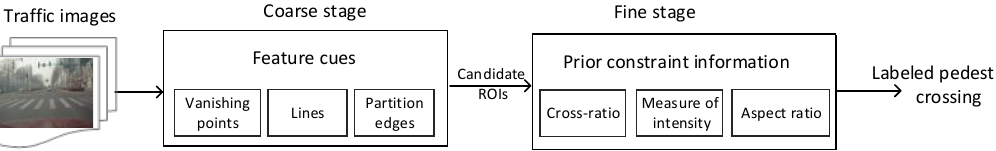
Figure 2. Operation flowchart, showing the coarse and fine stages of the proposed pedestrian crossing detection